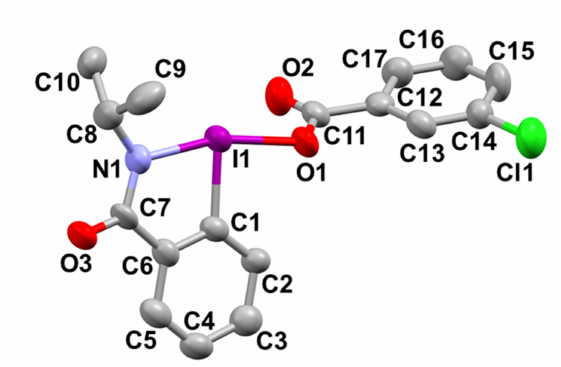
Figure 2. X-ray crystal structure of compound 5a . Typical bond distances in Å: I1–N1 = 2.126(5), I1–C1 = 2.085(5), I1–O1 = 2.174(4). C1 – C17 ; carbon atom, O1 – O3 ; oxygen atom; Cl1 ; chlorine atom; I1 ; iodine